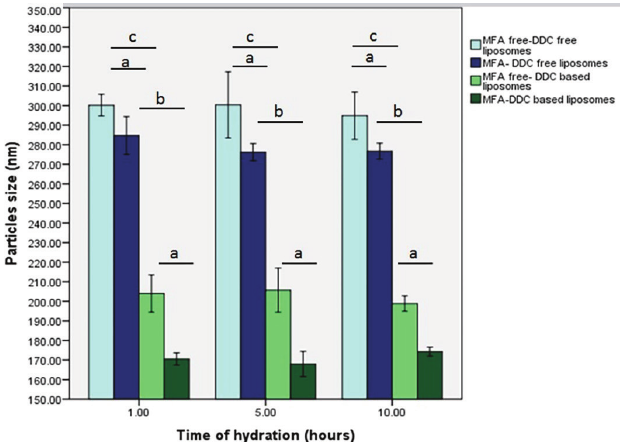
FIGURE 4 - Particle size (nm) when different liposomal components and hydration times were employed. (a) Indicates significant difference between MFA-loaded liposomes and their corresponding MFA free-liposomes by the Student’s t-test. (b) Indicates significant difference between MFA-DDC free liposomes and MFA-DDC based liposomes by the Student’s t-test. (c) Indicates significant difference between MFA free- DDC free liposomes and MFA free-DDC based liposomes by the Student’s t-test.